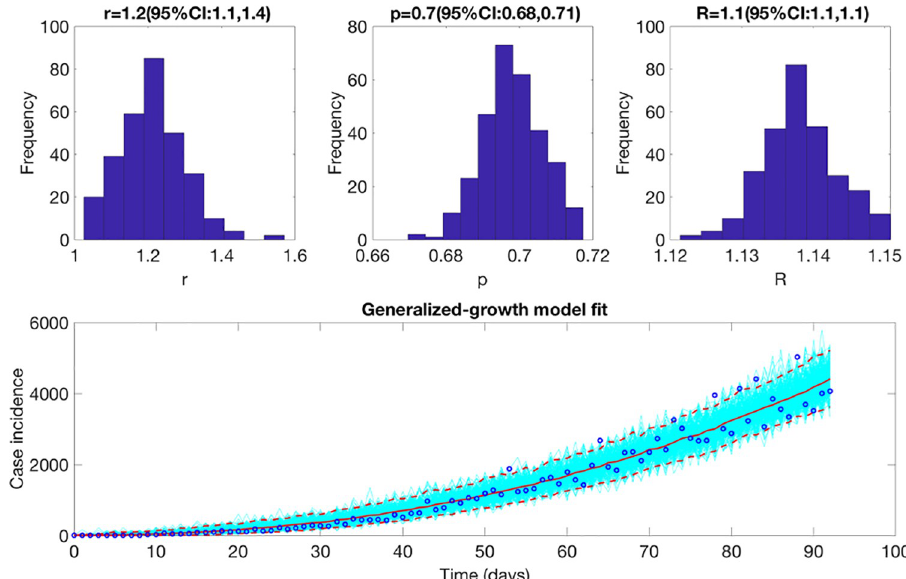
Fig 8. Upper panel: Reproduction number with 95% CI estimated using the GGM model. The estimated reproduction number of the COVID-19 pandemic in Mexico as of May 29, 2020, is 1.1 (95% CI: [1.1, 1.1]). The growth rate parameter, r , is estimated at 1.2 (95% CI: [1.1, 1.4]) and the deceleration of growth parameter, p , is estimated at 0.7 (95% CI: [0.68, 0.71]). Lower panel: The lower panel shows the GGM fit to the case incidence data for the first 90